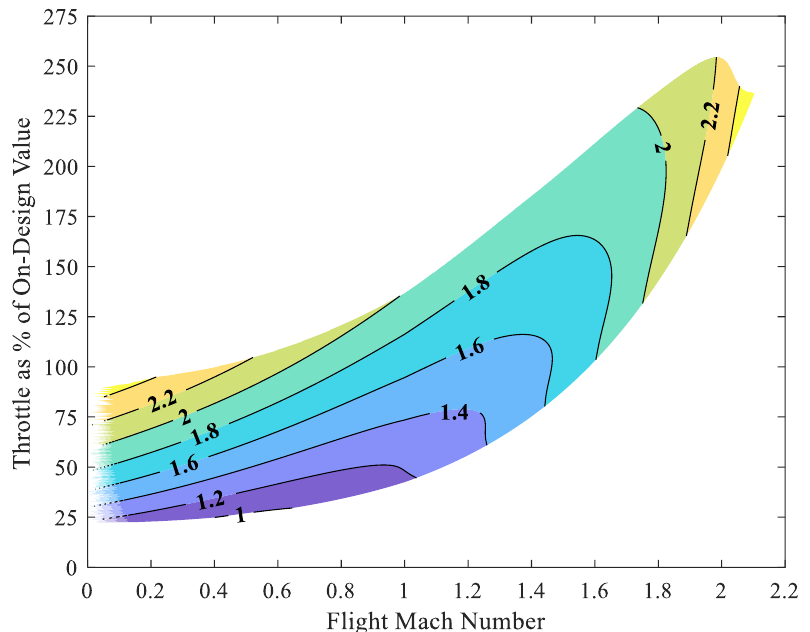
Figure 4. Ratio of entropy generation rate in the wake to entropy generation rate in the engine at 9 km altitude. km